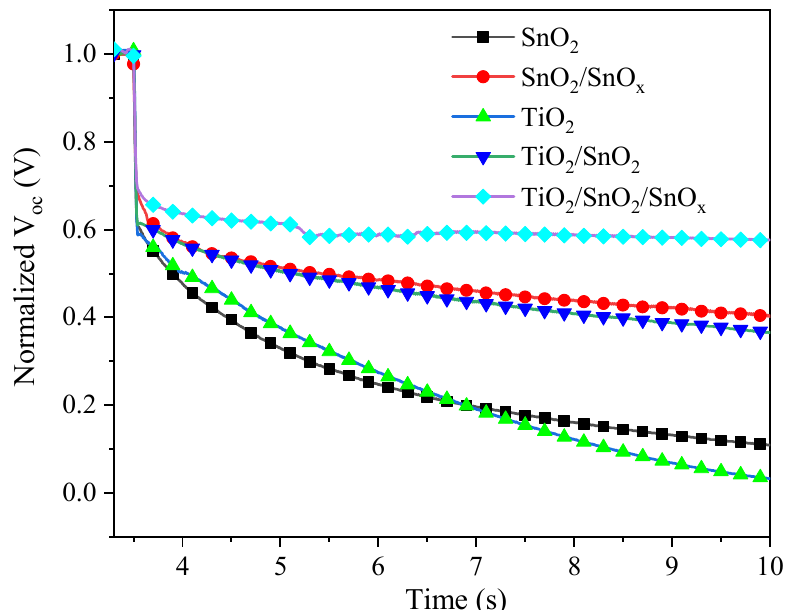
Figure 4. Voc decay of PSCs with the different conditions of ETL as a function of time after turning off the light. Table 2. OCVD fitted parameters from Equation (1) for PSCs with the different conditions of ETL. A 1 * and A 2 * are normalized coefficients obtained from a relation.